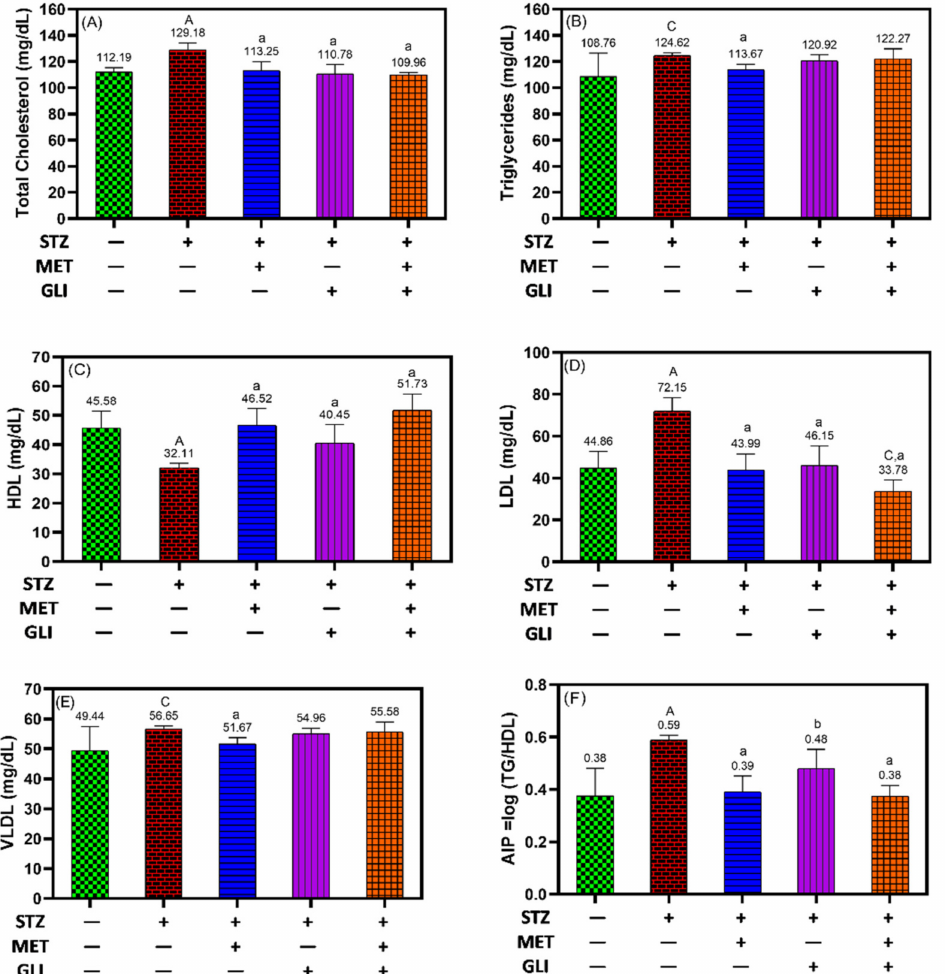
Figure 3. Effects of metformin, glipizide and their combination on lipid profiles in diabetic rats; ( A ) total cholesterol, ( B ) triglycerides, ( C ) HDL, ( D ) LDL, ( E ) VLDL, and ( F ) AIP. Each data is expressed as the Mean ± SD. A, B, and C notation (in capital letters) indicate the significant difference levels p < 0.001, p < 0.01, and p < 0.05 between studied groups and healthy controls, respectively. While a, b and c notation (in small letters) indicate the significant difference levels p < 0.001, p < 0.01, and p < 0.05 between studied groups and untreated DM groups,